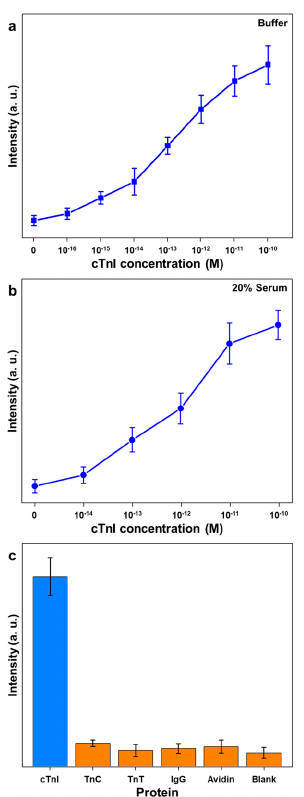
Figure 3. ( a ) Plot of 1580 cm − 1 band intensity versus cTnI concentration (0–10 − 10 M) in buffer. ( b ) Plot of 1580 cm − 1 band intensity versus cTnI concentration (0–10 − 10 M) in 20% serum. ( c ) Plot of 1580 cm − 1 band intensity versus proteins (cTnI, TnC, TnT, IgG, avidin, and control sample). The data represent the average plus standard deviation from ten measurements.